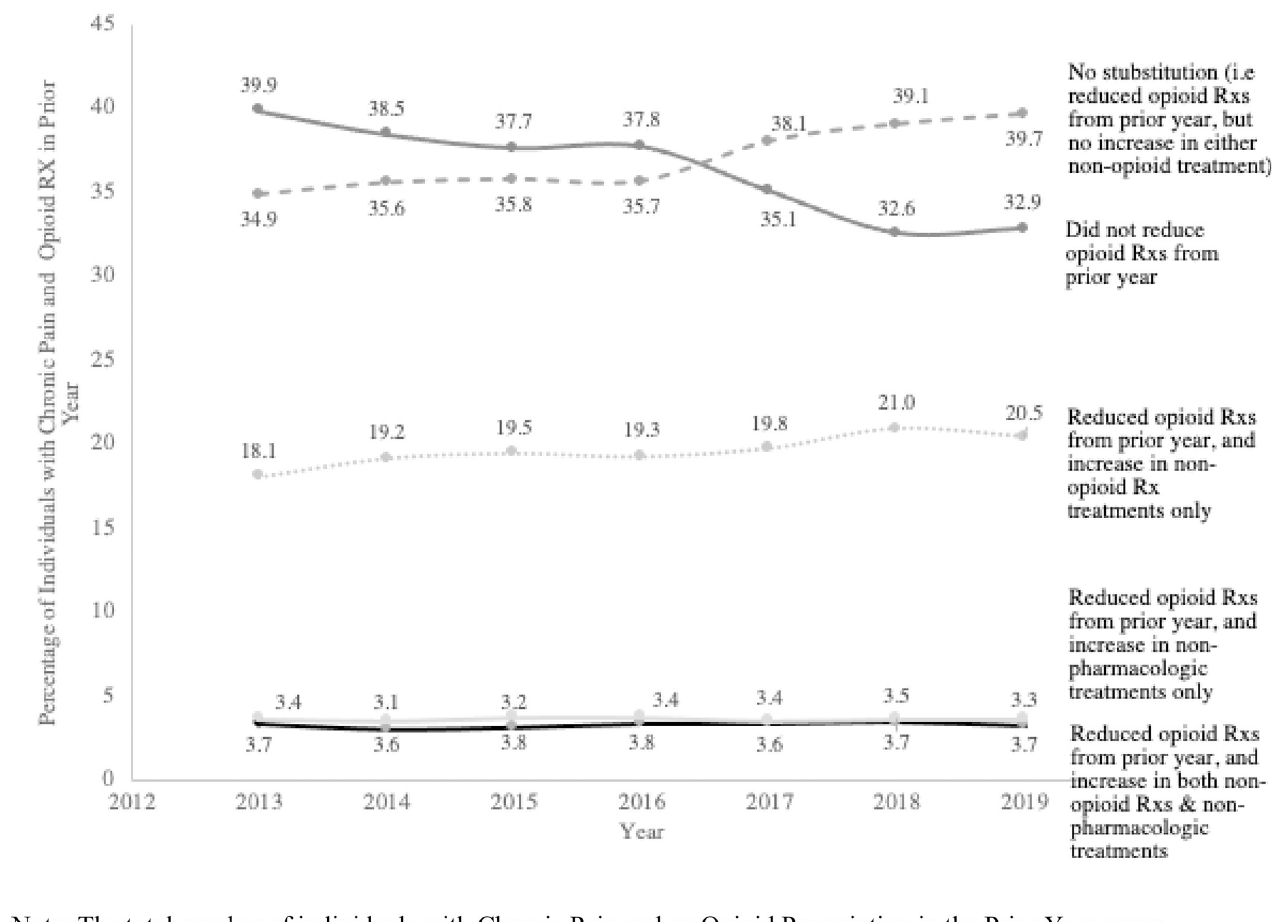
Fig 2. Year-to-year within-patient changes in chronic non-cancer pain treatment among patients with opioid prescriptions in the prior year.